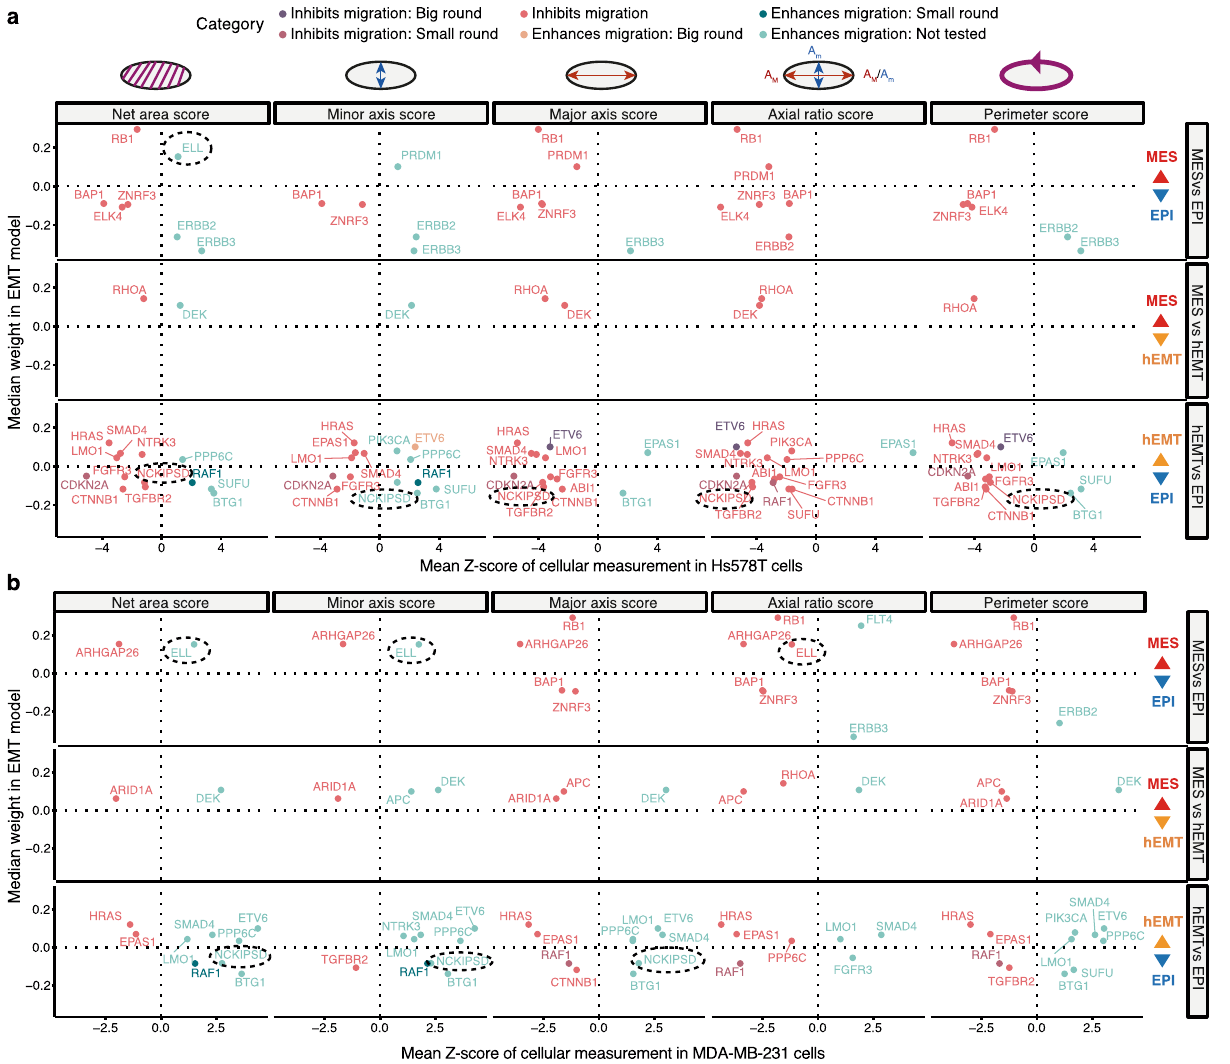
coloured according to the suggested phenotype by the respective cellular mea- surement.Afewofthegeneshighlightedhaveundergonefurtherphenotypictests andthisisindicatedbythecon fi rmedphenotype(big/smallround).Therestofthe genes were not further tested in the study (Not tested). Only candidates with a Z score value of cellular measurement >1 or < − 1 are shown. The genes ELL